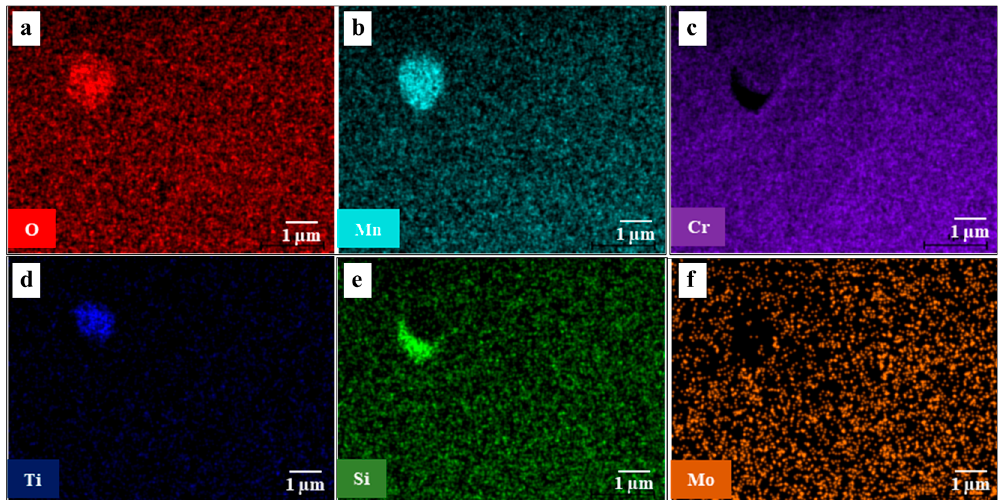
Figure 2. Elemental distribution of small oxide inclusions by EDS-TEM: ( a ) oxygen; ( b ) manganese; ( c ) chromium; ( d ) titanium; ( e ) silicon; ( f ) molybdenum. Table 1. EDS point analysis of the oxides, corresponding to Figures 3 and 4. Element